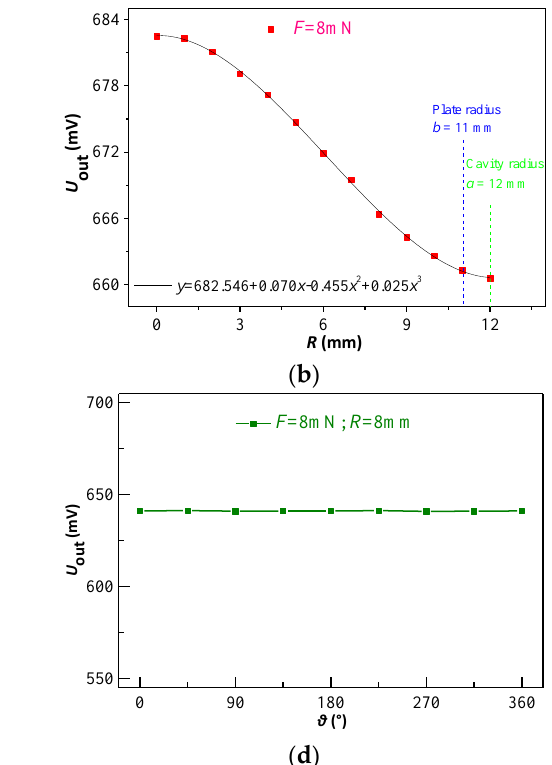
Figure 6. The tip diameter is 0.01 mm in all tests. ( a ) Experimental curve of the contact force vs. the output voltage. ( b )Experimental curve of the polar radius of the contact force action point vs. the output voltage. ( c ) Fitting of the curve surface. ( d ) Experimental curve of the polar angle of the contact force action points vs. the output voltages.